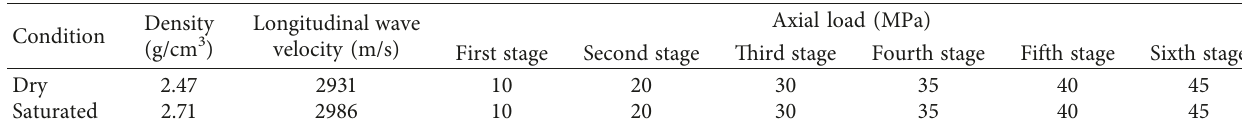
Table 1: Level of axial